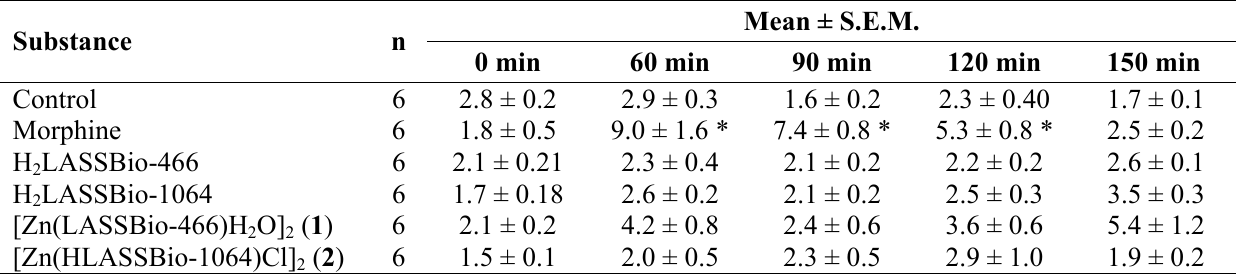
Table 5. Time course effect of prototypes H zinc(II) complexes (100 µmol·kg − 1 , p.o.) and morphine (15 µmol·kg − 1 , i.p.) on hot-plate test in mice.